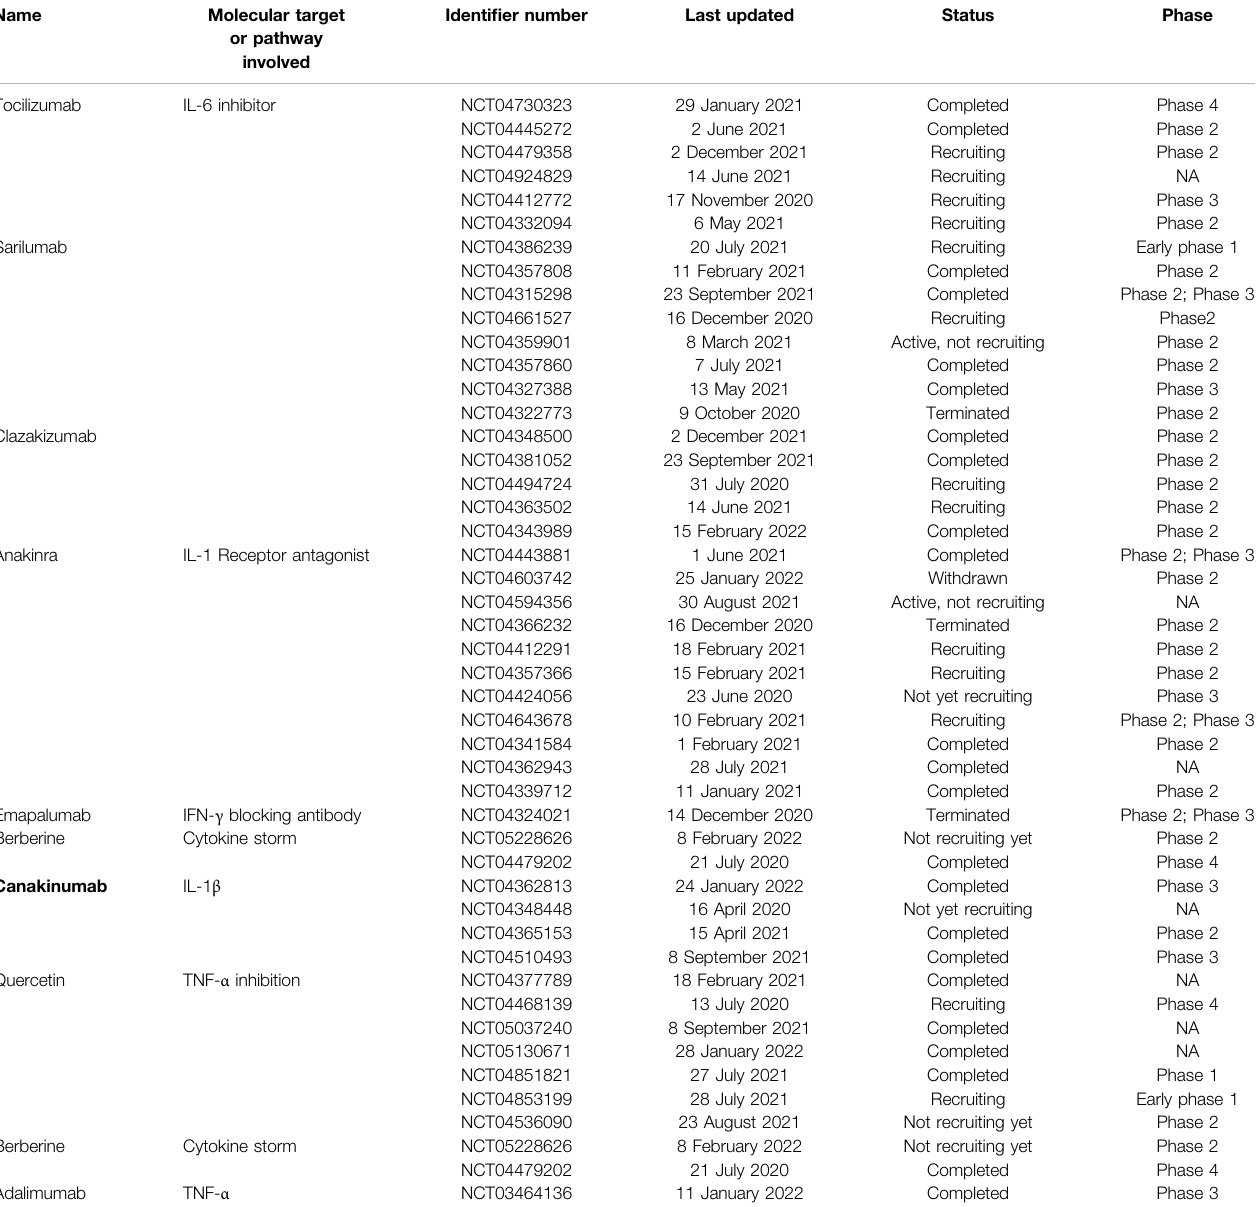
TABLE 5 | Clinical trials of the drugs targeting cytokines different signaling molecules involved in the immune response against